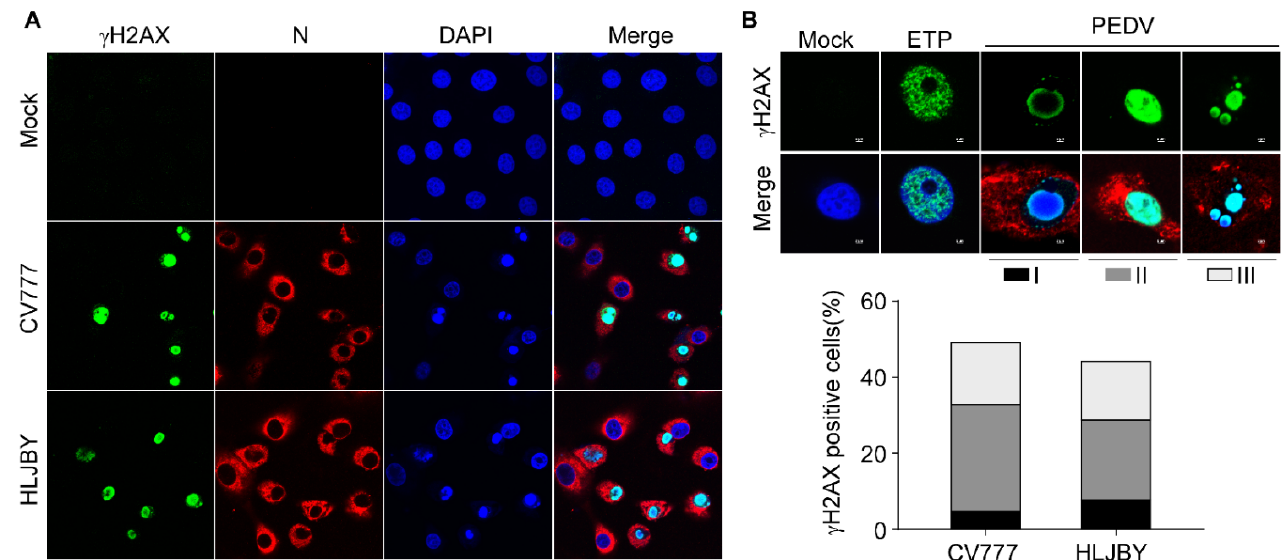
Figure 4. The pan ‐ nuclear staining of γ H2AX in PEDV ‐ infected Vero ‐ E6 cells. ( A ) Confocal images are representative of γ H2AX immunofluorescence staining in Vero ‐ E6 cells infected with PEDV (1 MOI) for 30 h. γ H2AX was labeled in green, PEDV N was labeled in red, and nuclei were stained in blue with DAPI. ( B ) Representative confocal images of a single cell showing the γ H2AX patterns in different phases (600× magnification). From left to right: untreated cells, etoposide ‐ treated cells, and CV777 infected cells. The graph shows the relative distribution of the different γ H2AX patterns (over 100 cells). Black columns correspond to peripheral nuclear staining (ring pattern, I), dark gray columns correspond to pan ‐ staining (flooded pattern, II), and light gray columns correspond to apoptotic bodies fully stained with γ H2AX (III).